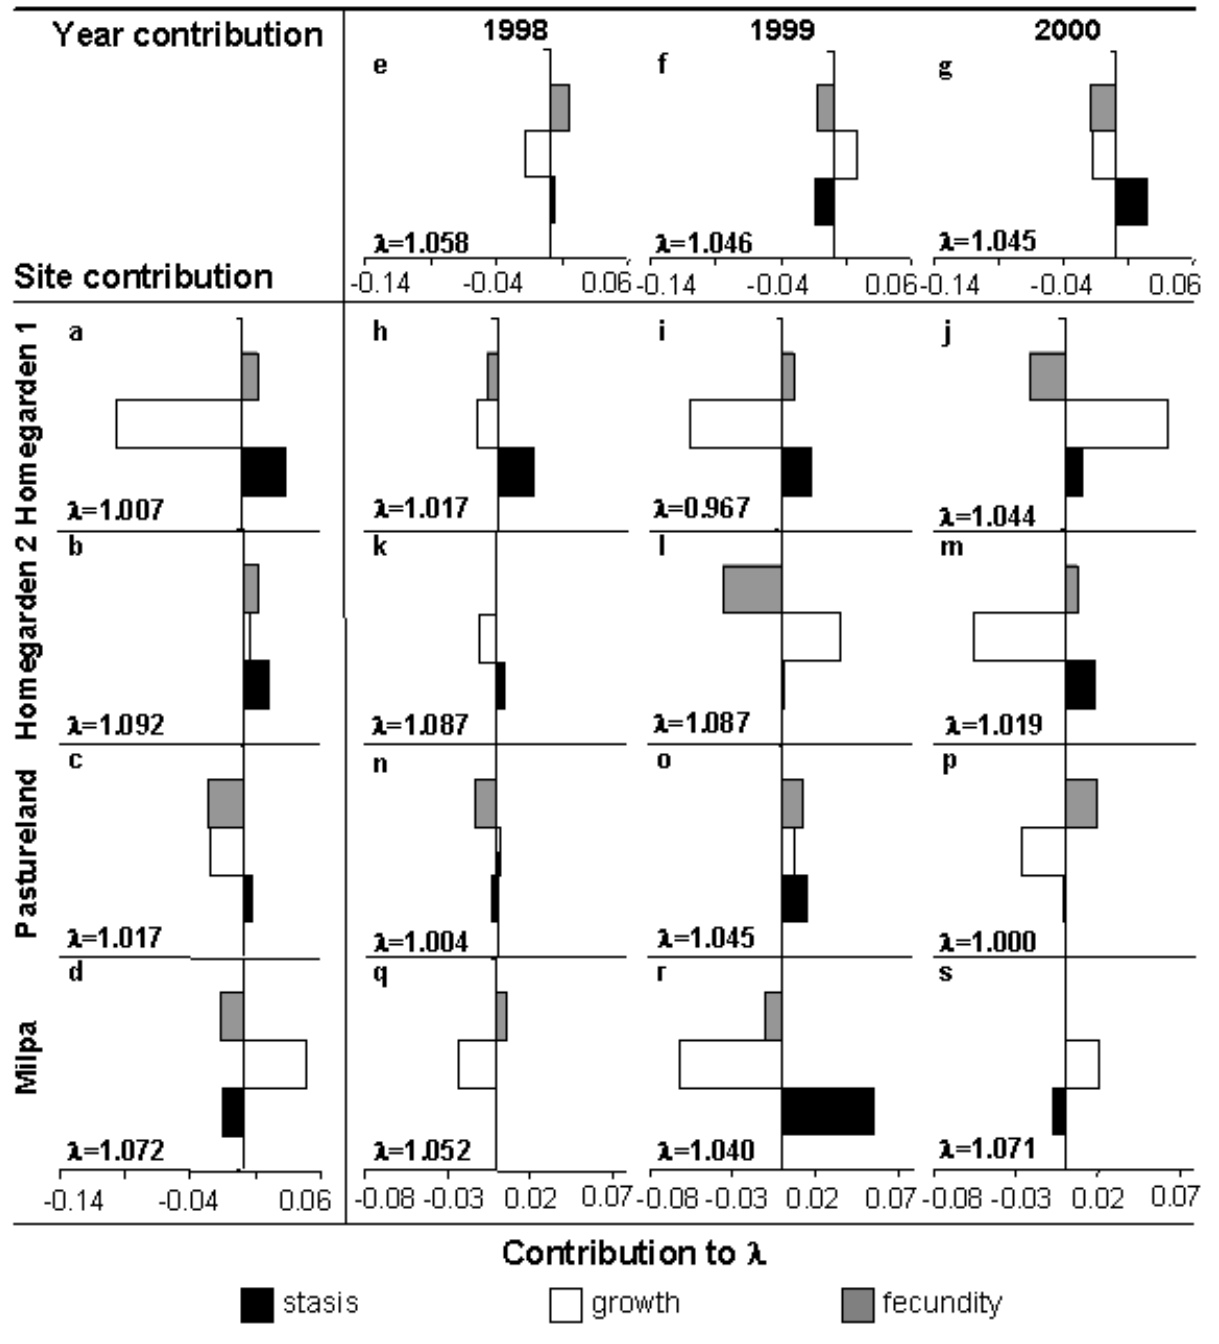
Fig. 3. Vital rate (stasis, growth, and fecundity) contributions to the difference between the populations’ finite growth rates, l . Differences are broken down into site contributions (a–d), year contributions (e– g), and site x year interactions (h–s). In the latter, sites are arranged in rows and years in